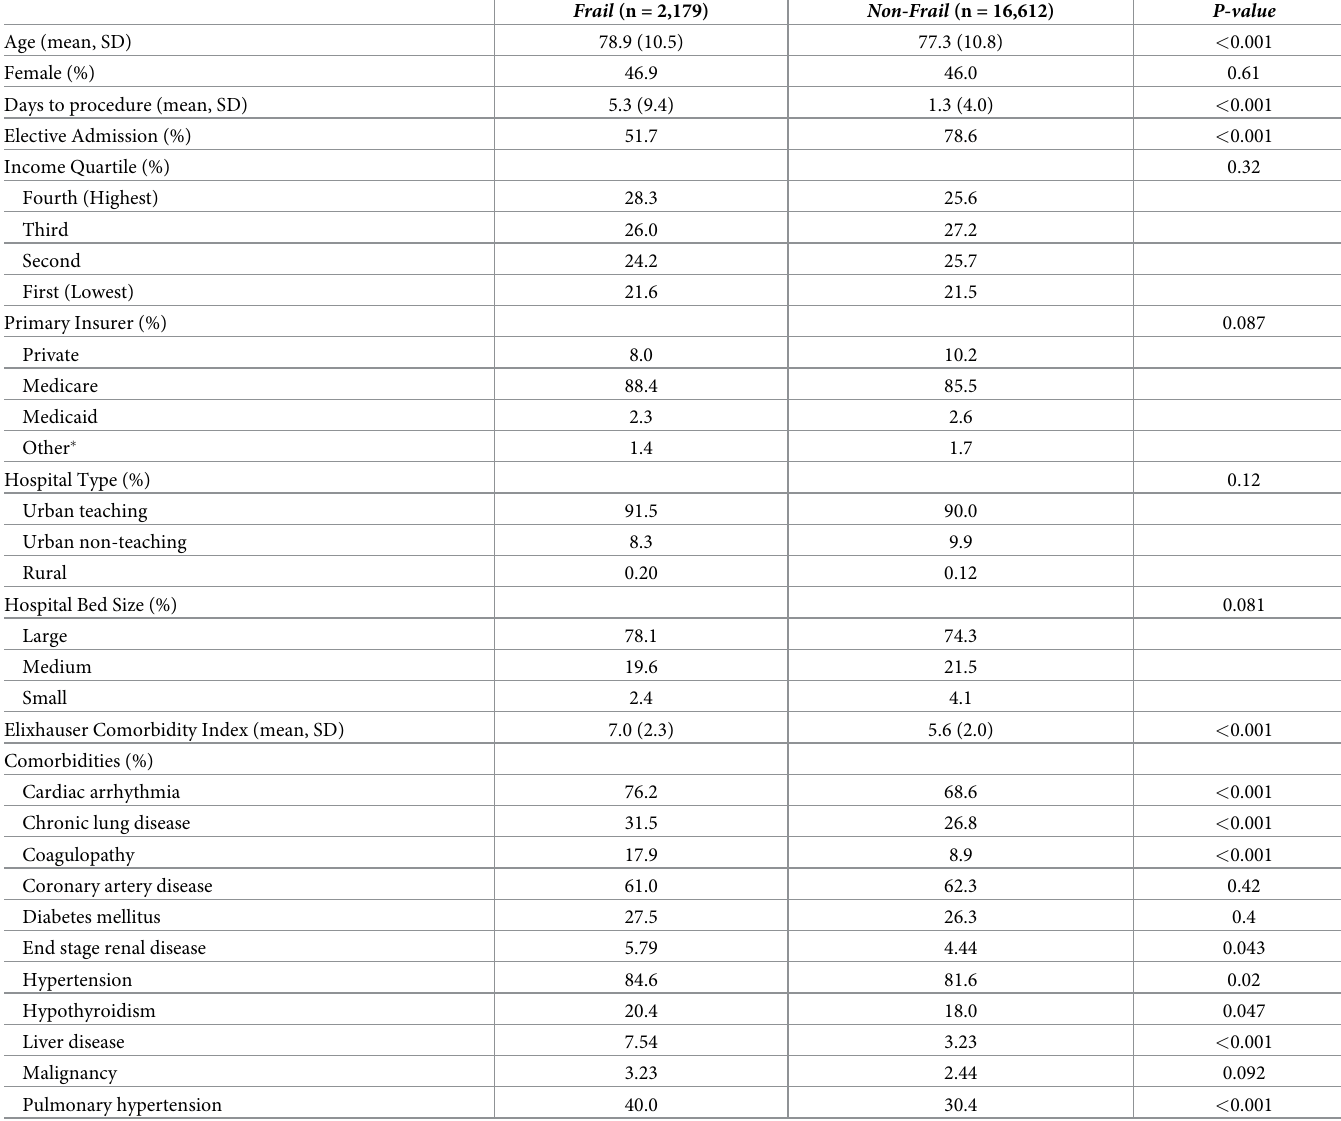
Table 1. Patient and hospital characteristics of patients undergoing TMVR from 2016–2018 by frail and non-frail